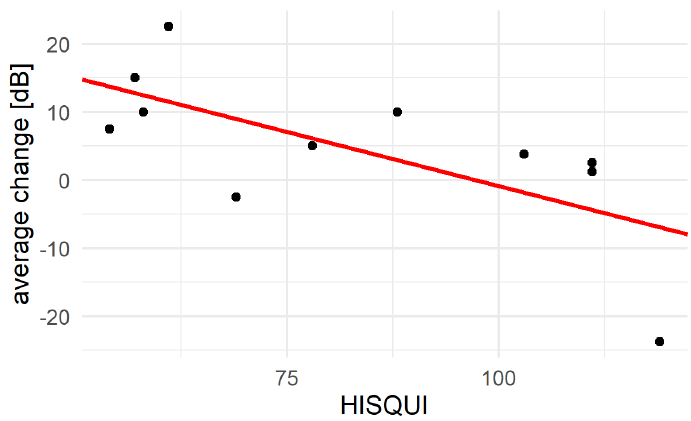
Figure 5. Correlation between change of inner ear function (BC) and the Hearing Implant Sound Quality Index (HISQUI). The individual values are shown as black dots, the correlation is show with the red line.